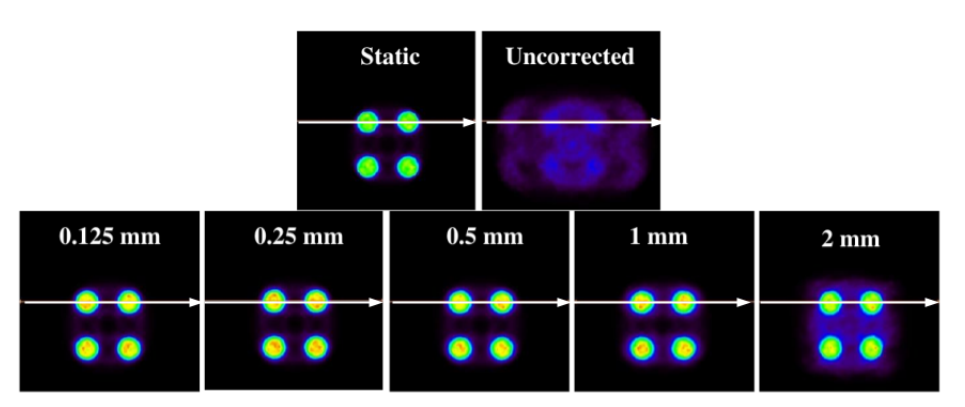
Figure 10. Reconstructed phantom for different voxel sizes with Bernoulli’s lemniscate motion in two dimensions. Images above: ( left ) static image; ( right ) uncorrected movie clip. Images below: images corrected for voxel size ratios of a = 0.125, a = 0.25, a = 0.5, a = 1, and a = 2, respectively. The white line indicates the line where the respective profiles were